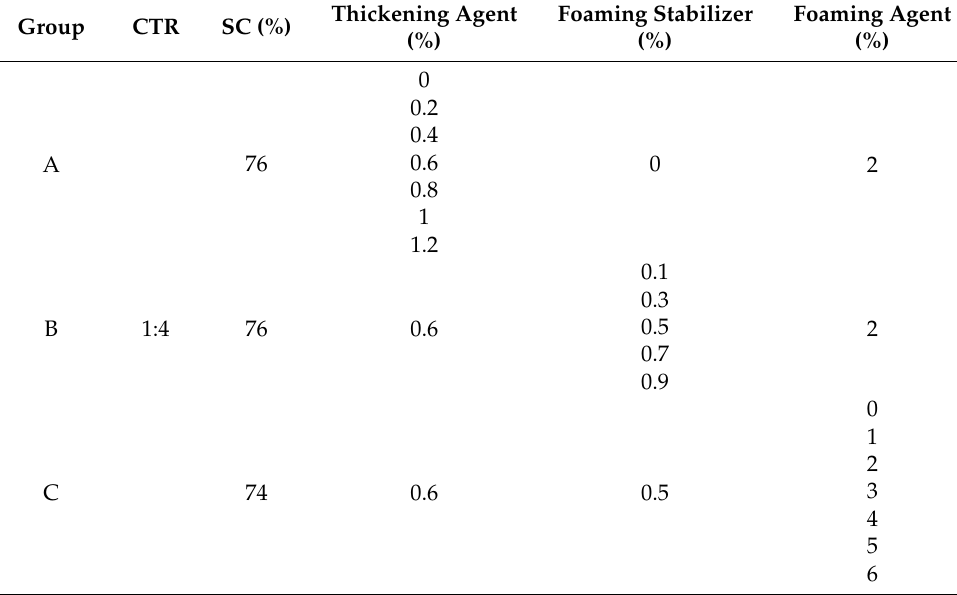
Table 2. Determination of optimal admixture contents.